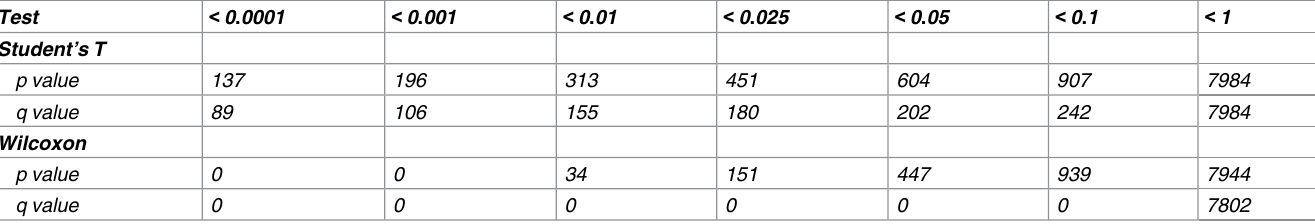
Table 2. Cumulative number of significant results for 7984 genes with 2 or more somatic